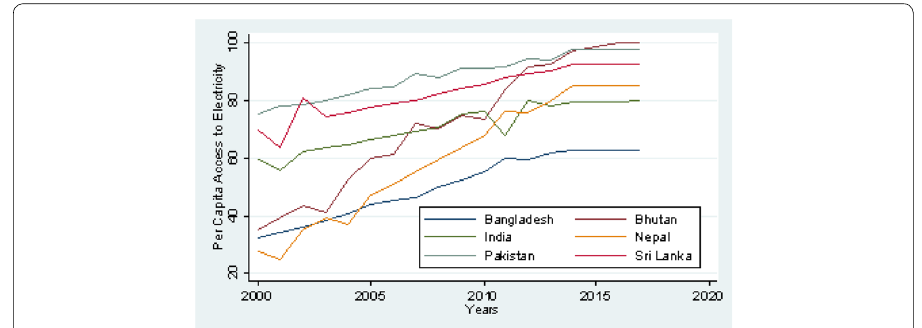
Fig. 1 Per capita access to electricity (source: World Development Indicators (WDI))